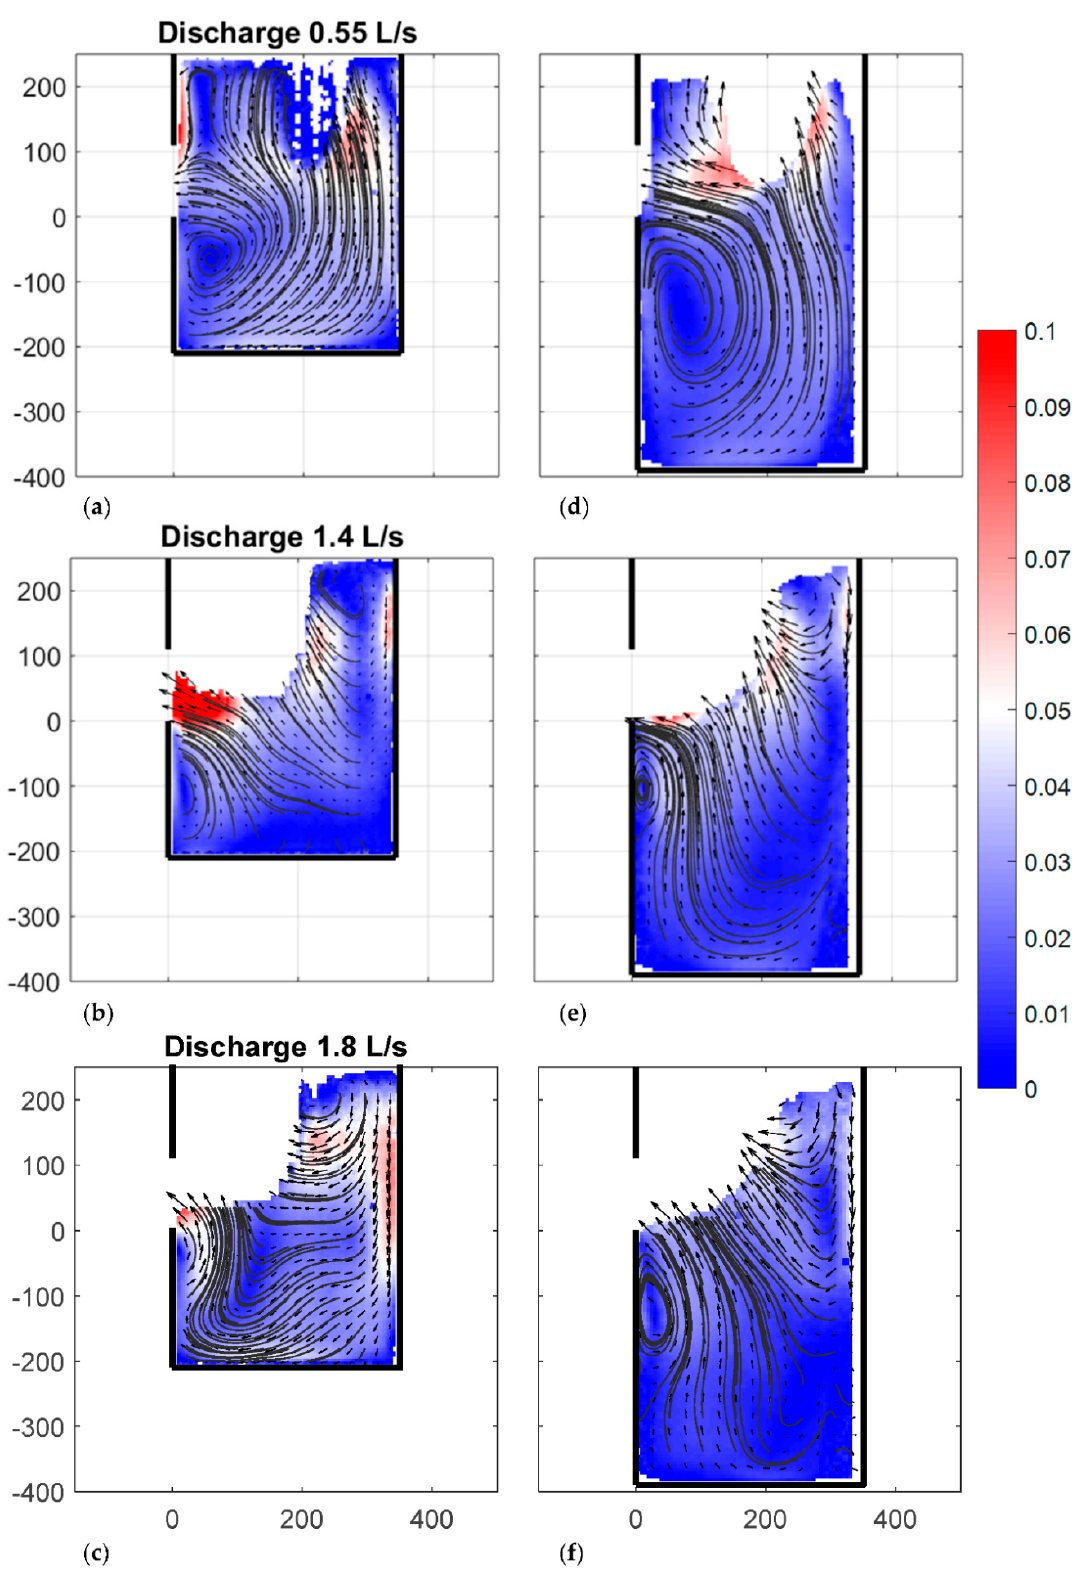
Figure 16. The effect of the gully pot depth on the flow field at several discharges. ( a – c ) Gully pot with depth 0.21 m; ( d – f ) Gully pot with depth 0.39 m.